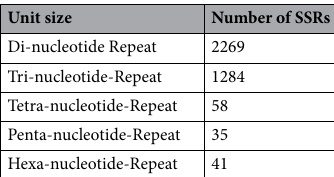
Table 3. Overall abundance of SSRs repeat motifs in transcripts encoding transcription factor genes of tea.